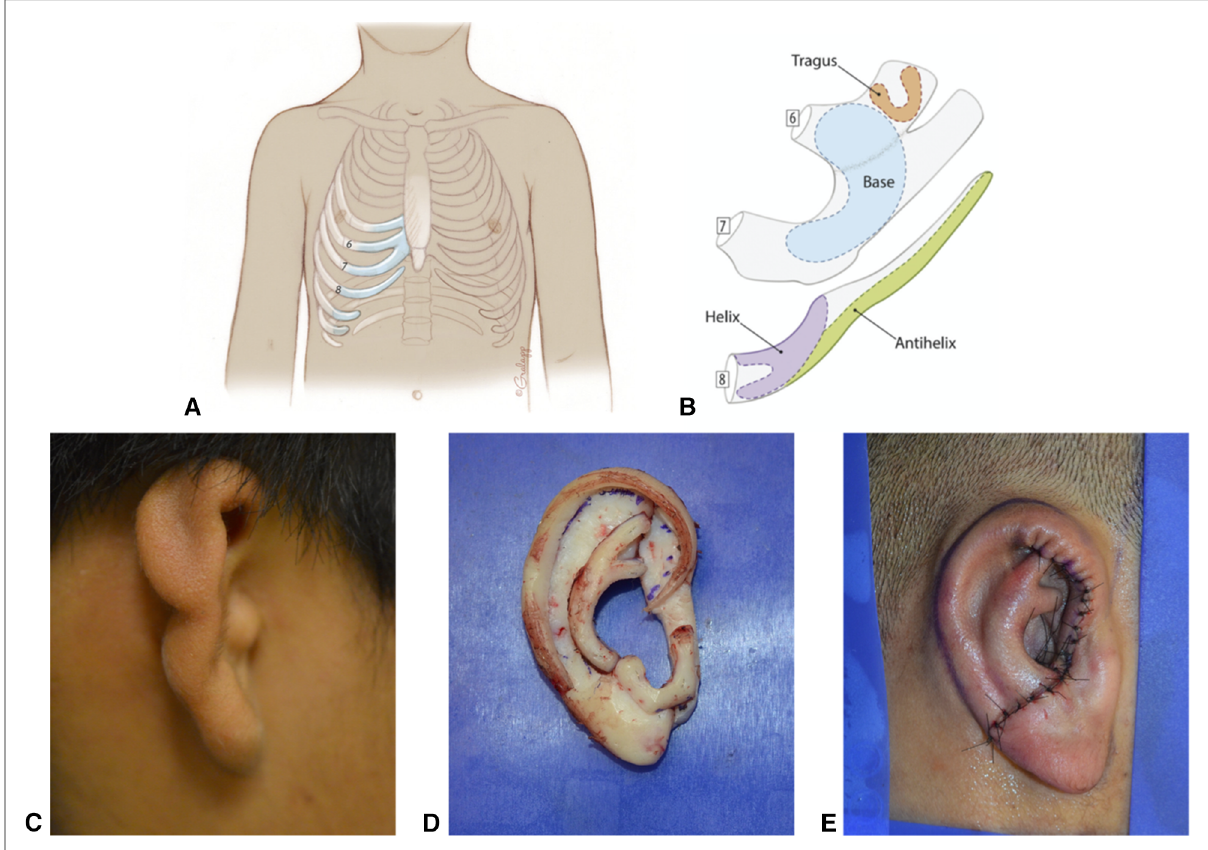
FIGURE 10 Autologous Cartilage Reconstruction. ( A ) Typical areas of costochondral cartilage harvest. ( B ) Example of auricular subunits created from costochondral cartilage. ( C ) Pre surgical picture of microtic ear. ( D ) Assembled costochondral auricular framework. ( E ) Immediate postoperative appearance after Stage 1 costochondral cartilage